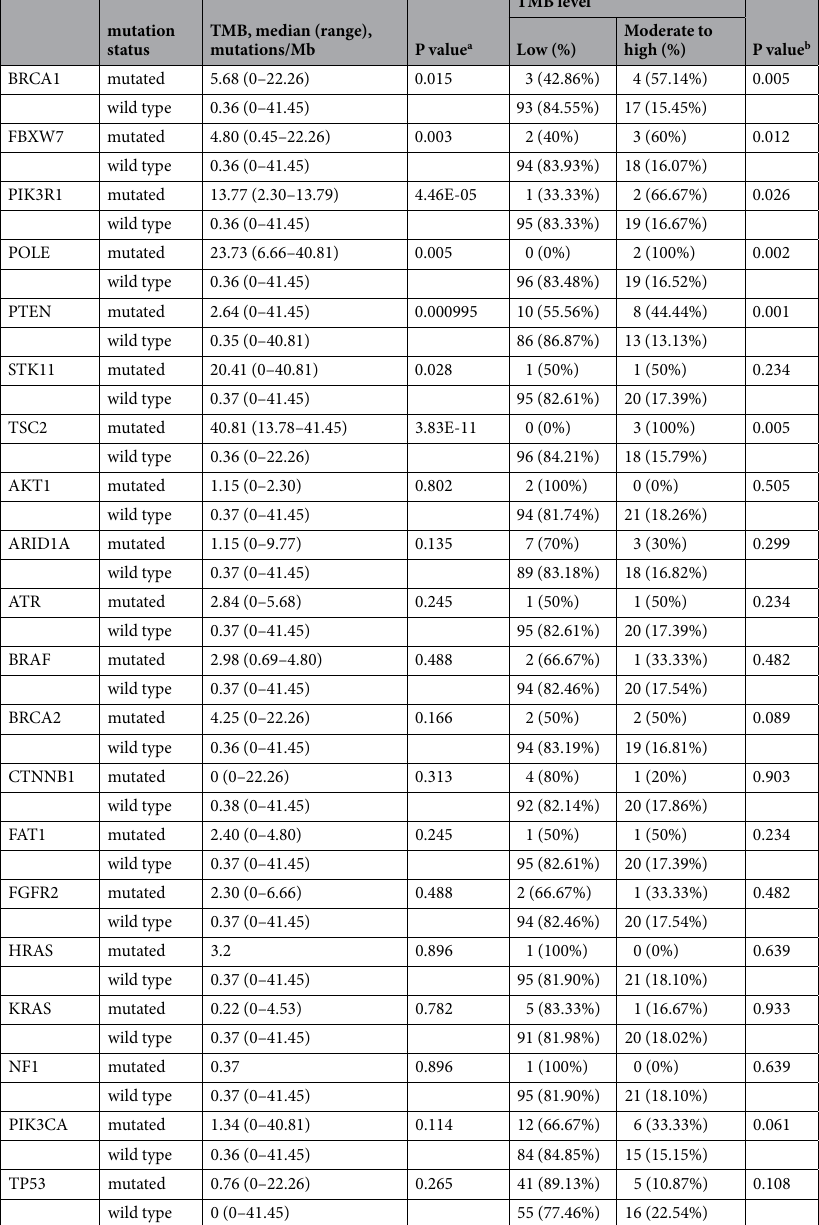
Table 3. The association of TMB levels and genomic alterations. Note: a calculated using Mann-Whitney test/ Kruskal-Wallis test. b Calculated using Pearson’s chi-square